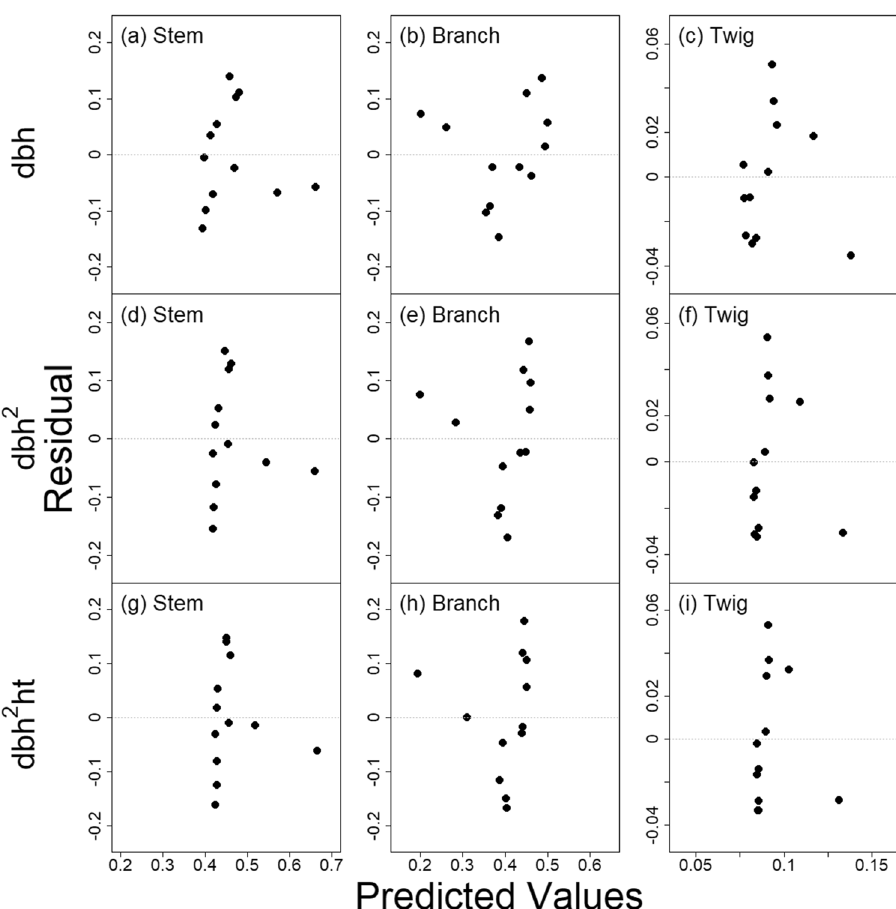
Figure 1. Residuals vs. predicted values of three Nonlinear Seemingly Unrelated Regression models (Eq. 1). The three predictors are: (a–c) dbh, (d–f) dbh 2 , and (g–i) dbh 2 ·ht. Each NSUR model consists of three Component Ratio Models (CRM) for the three biomass components: (a,d,g) main stem, (b,e,h) large branch, and (c,f,i)